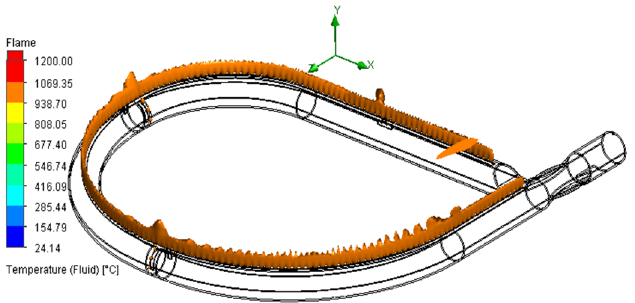
Figure 4. Combustion simulation of the original combustion tube.